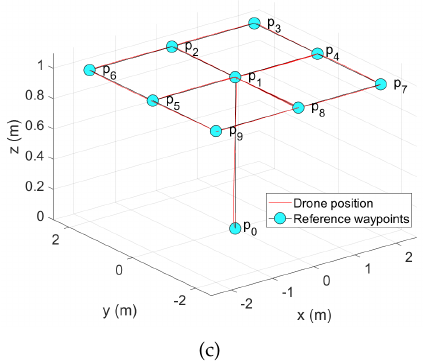
Figure 13. Drone’s absolute position obtained with the simulation in Simulink. ( a ) First movement trajectory tracking with the simulated model of the UAV. ( b ) Second movement trajectory tracking with the simulated model of the UAV. ( c ) Third movement trajectory tracking with the simulated model of the